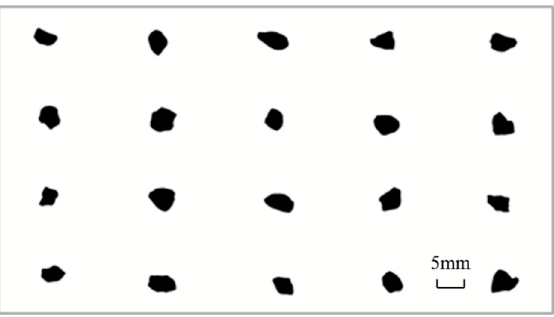
Figure 12. Example of the 20 projections imaged from MSA.